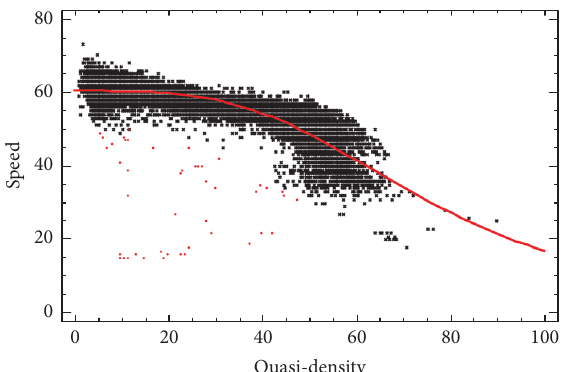
Figure 10: Speed versus density with the estimated BPR function, V 0 and 𝑘 max (red), solution of the extended estimation problem